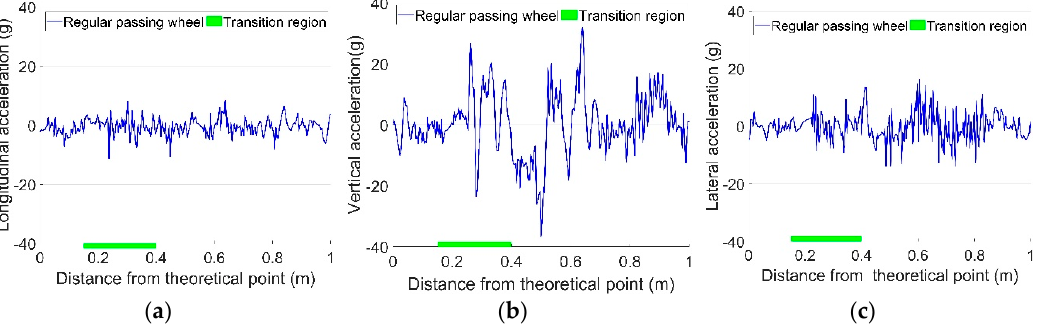
Figure 7. Examples of regular impact acceleration responses due to passing wheels. (a) Longitudinal acceleration; (b) Vertical acceleration; (c) Lateral acceleration. acceleration; ( b ) Vertical acceleration; ( c ) Lateral acceleration.